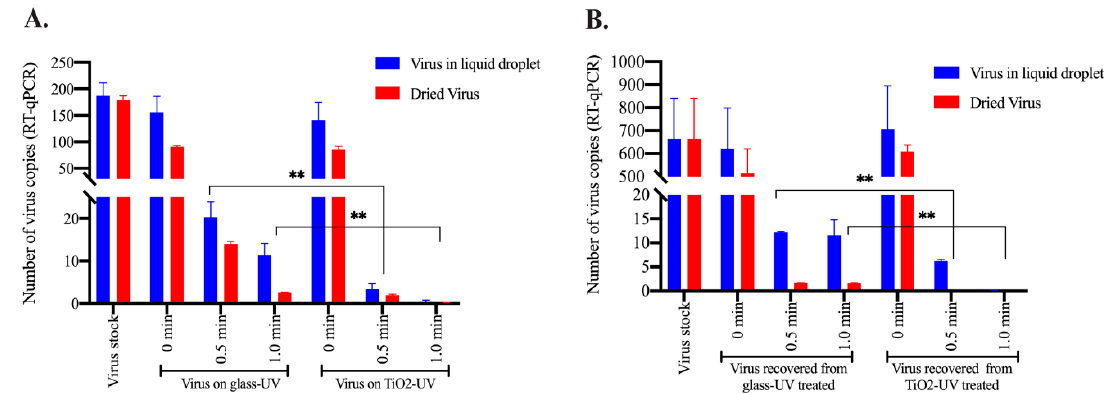
Figure 4. TNP-coated surface efficiently inactivated virus present in wet or dried form. HCoV-NL63 virus was deposited as 10 μ L droplets at 10 spots (100 μ L total) on on glass coverslips treated with or without TiO 2 . One set was allowed to dry, which took ~20min to visibly dry before exposing to the UV light. Another set was exposed to the UV-light immediately after depositing the virus on control or the TNP surface. Virus copies were recovered by adding PBS. ( A ) Total RNA was extracted for the quantitation of intact viral genome copies through RT-qPCR. ( B ) Virus recovered in PBS was added onto a monolayer of HEK293L cells, allowed to grow for 48h after removing the unattached virus after 2 h. Total RNA from the infected cells were extracted for the quantitation of intracellular viral copies, following infection with residual infectious virus. Statistical analyses were performed using Prism 8.0 software and the p -values were calculated using 2-way ANOVA and the p -values are ** <0.01.